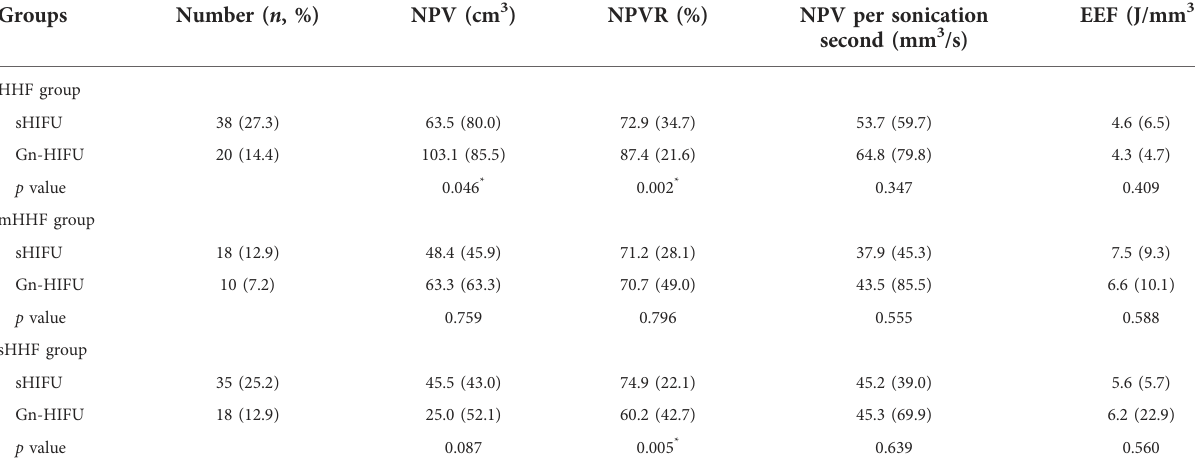
TABLE 4 Comparison of ultrasound ablation results in different sub-types of hyperintense uterine fi broids on T2WI between the sHIFU group and the Gn-HIFU group after cohort matching.